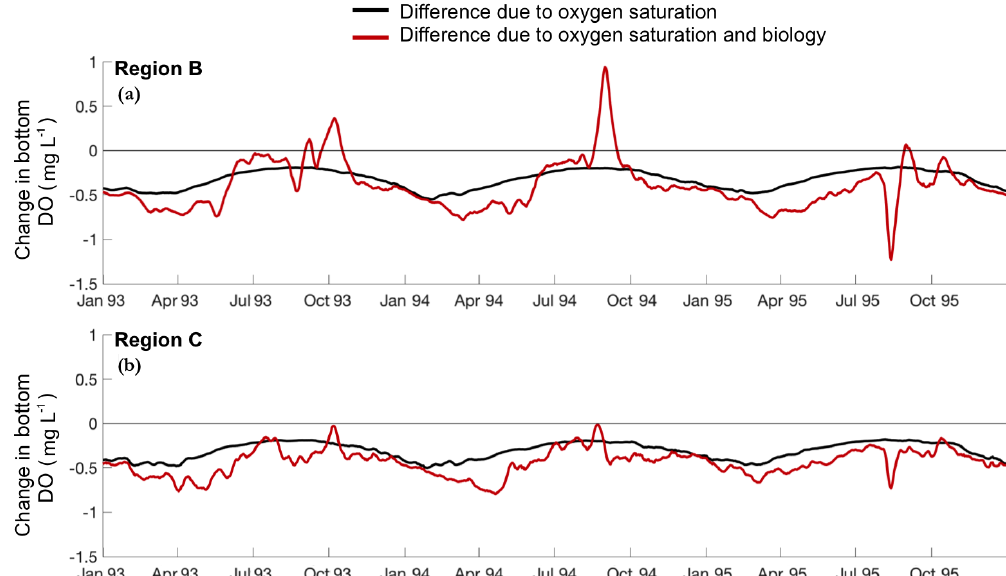
Figure 6. DO differences due to climate change (between the TMDL + noCC and TMDL + tempCC scenarios) averaged for (a) the stations in Region B and (b) the stations in Region C. The black lines are the average change expected if only solubility was impacted by an increase in temperature. The red lines are the modeled change in DO as a result of the increase in temperature affecting both solubility and biological oxygen